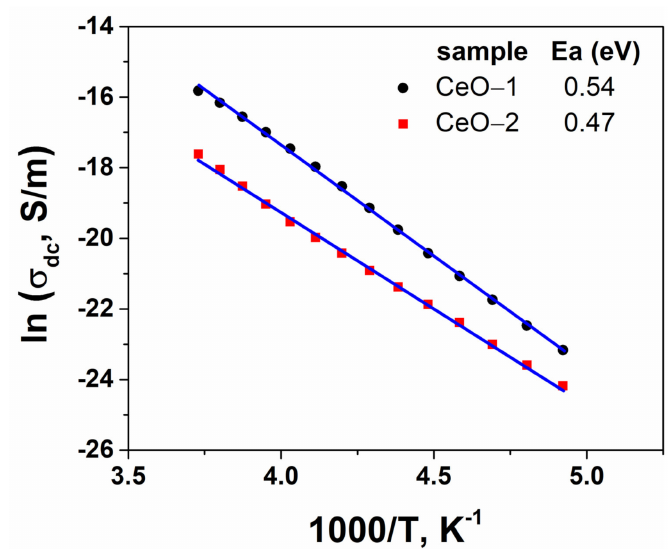
Figure 12. Temperature dependence of conductivity for cerium oxide